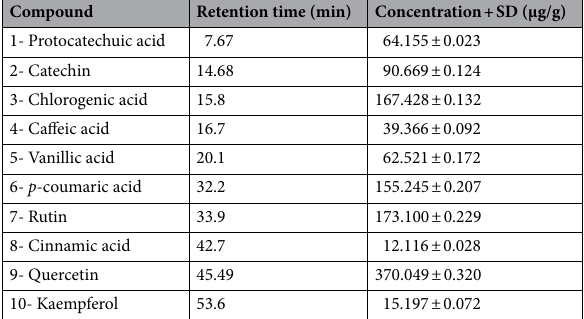
Table 2. Flavonoid and phenolic acid content of L. hispidulus ethanolic